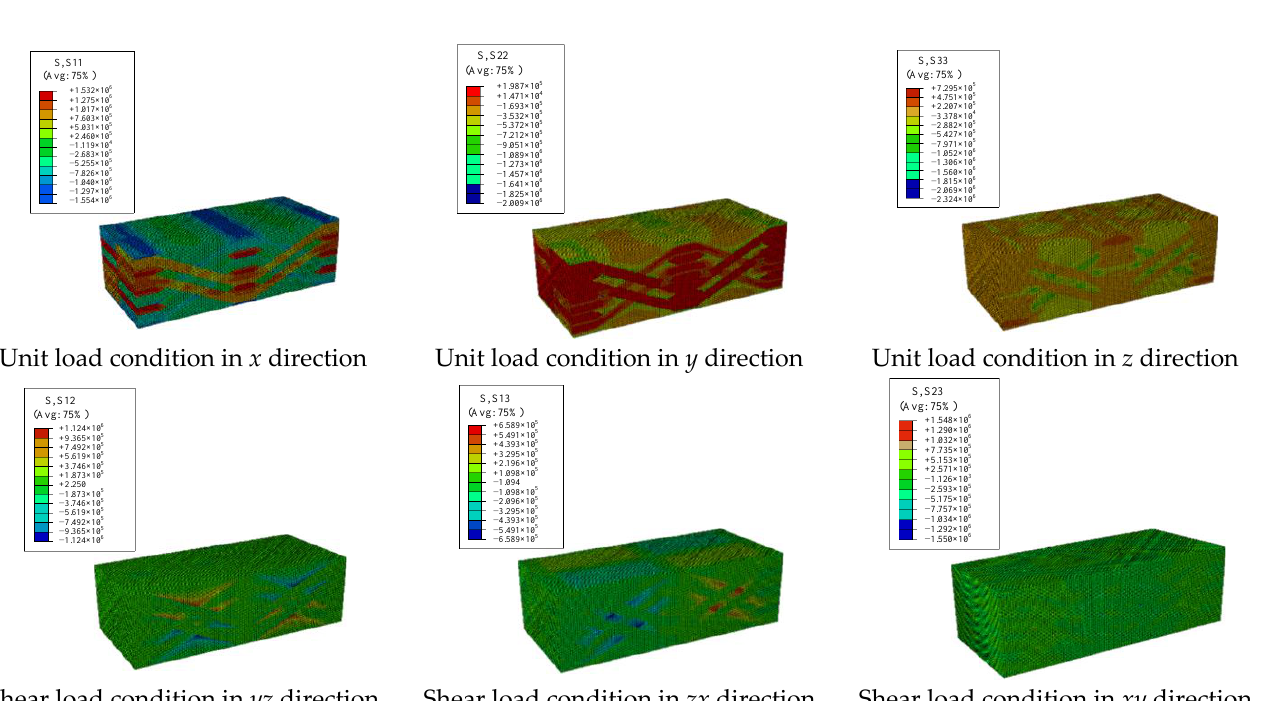
Figure 12. The stress distribution under different load boundary conditions.